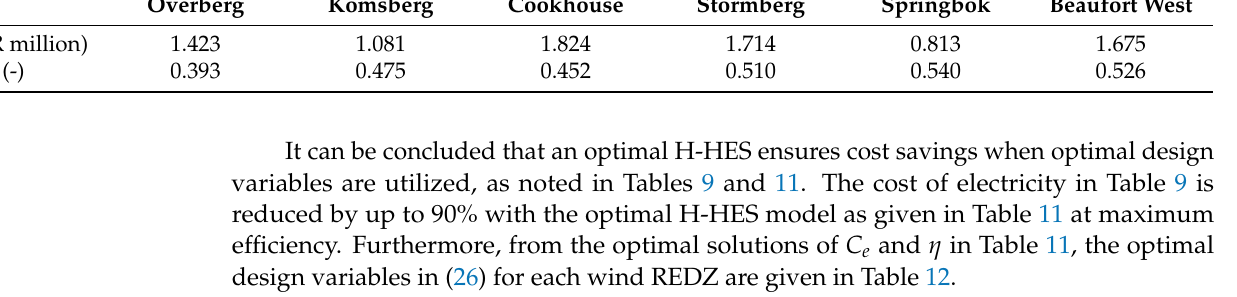
Figure 12. Scaled Pareto fronts and scaled best solutions (presented by X) for the wind REDZs.